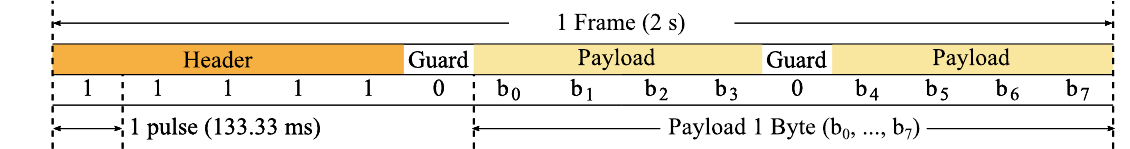
Figure 5. Frame format used by both of the T x devices of the sub-pixel experiment, assuming a global shutter demodulation at the R x